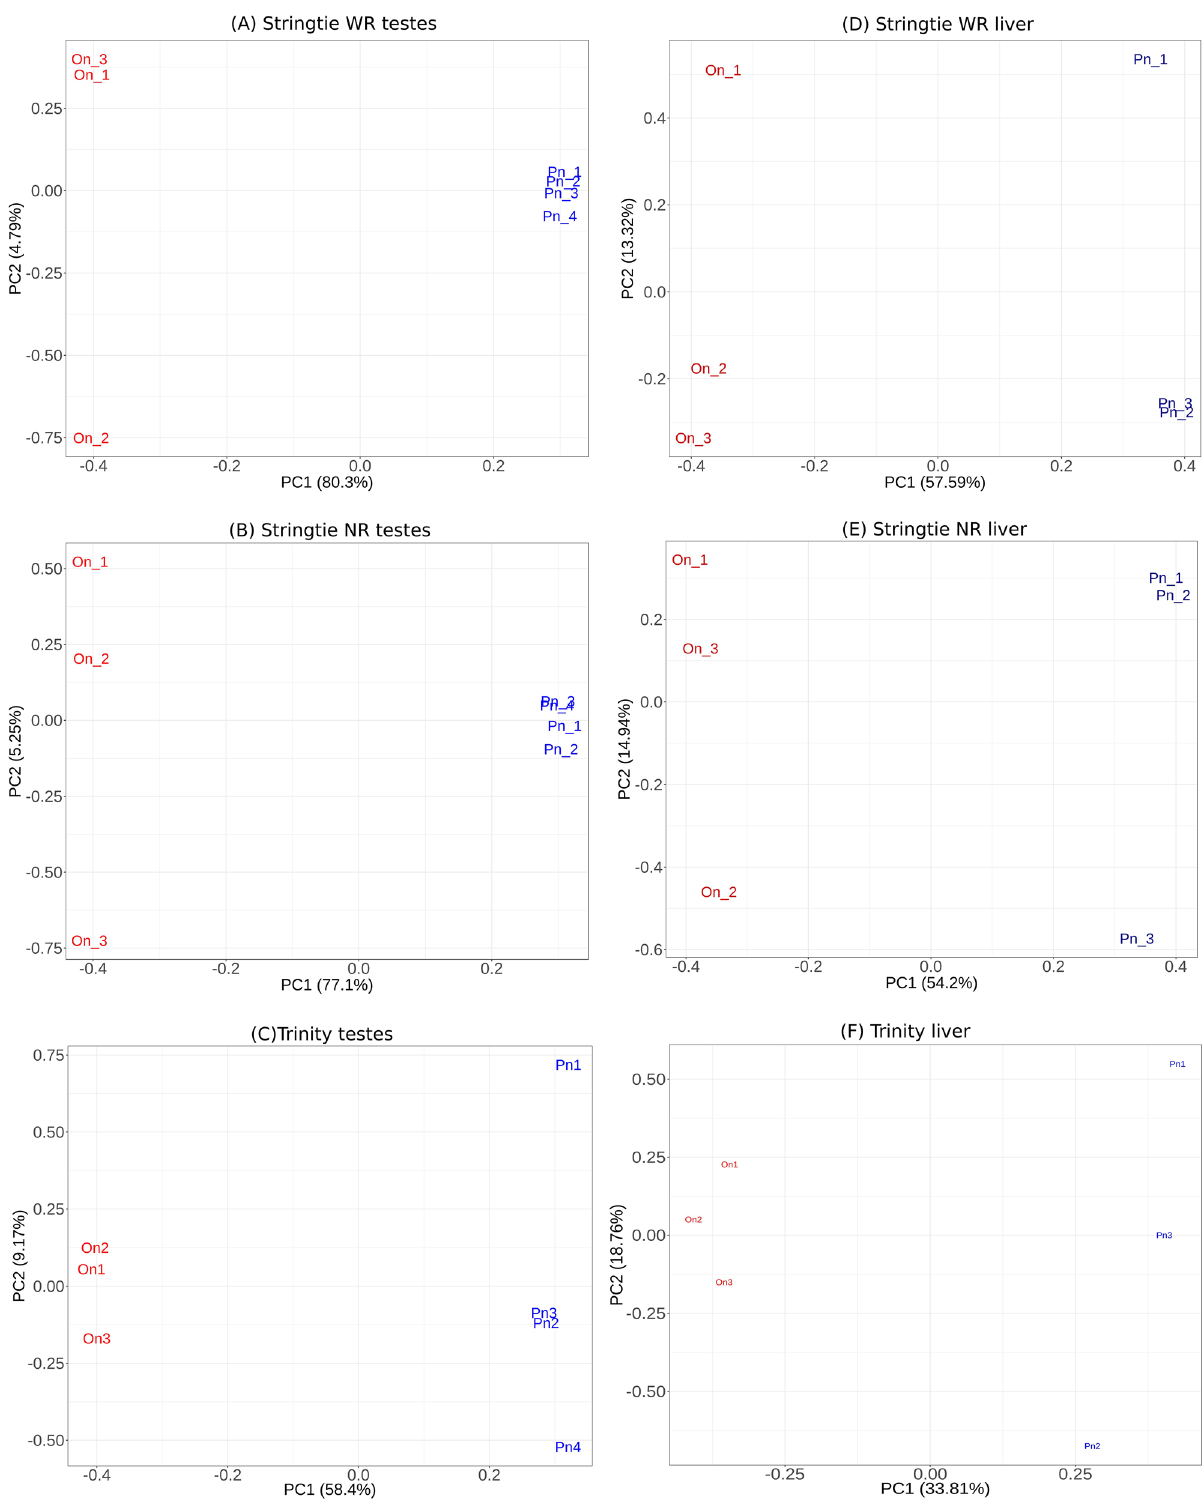
Figure 3. Principal component analysis. Plots for each tissue type and transcriptome assembly method of the samples separated based on FPKM values of orthologous transcripts. ( A ) Stringtie WR testes. ( B ) Stringtie NR testes. ( C ) Trinity testes. ( D ) Stringtie WR liver. ( E ) Stringtie NR liver. ( F ) Trinity liver. In both the tissues, for all the three assembly methods, the samples for two fishes separate over the first principal component and form separate